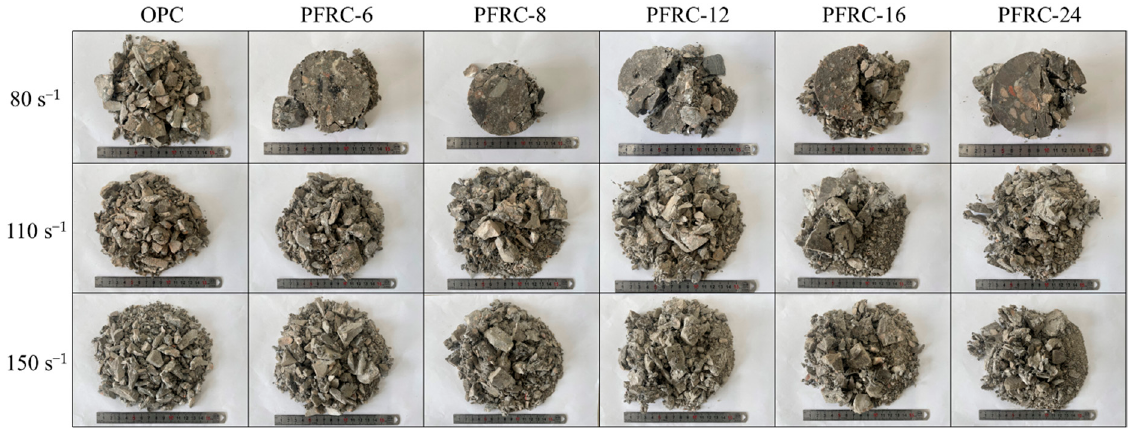
Figure 6. Failure patterns of specimens under different strain rates.